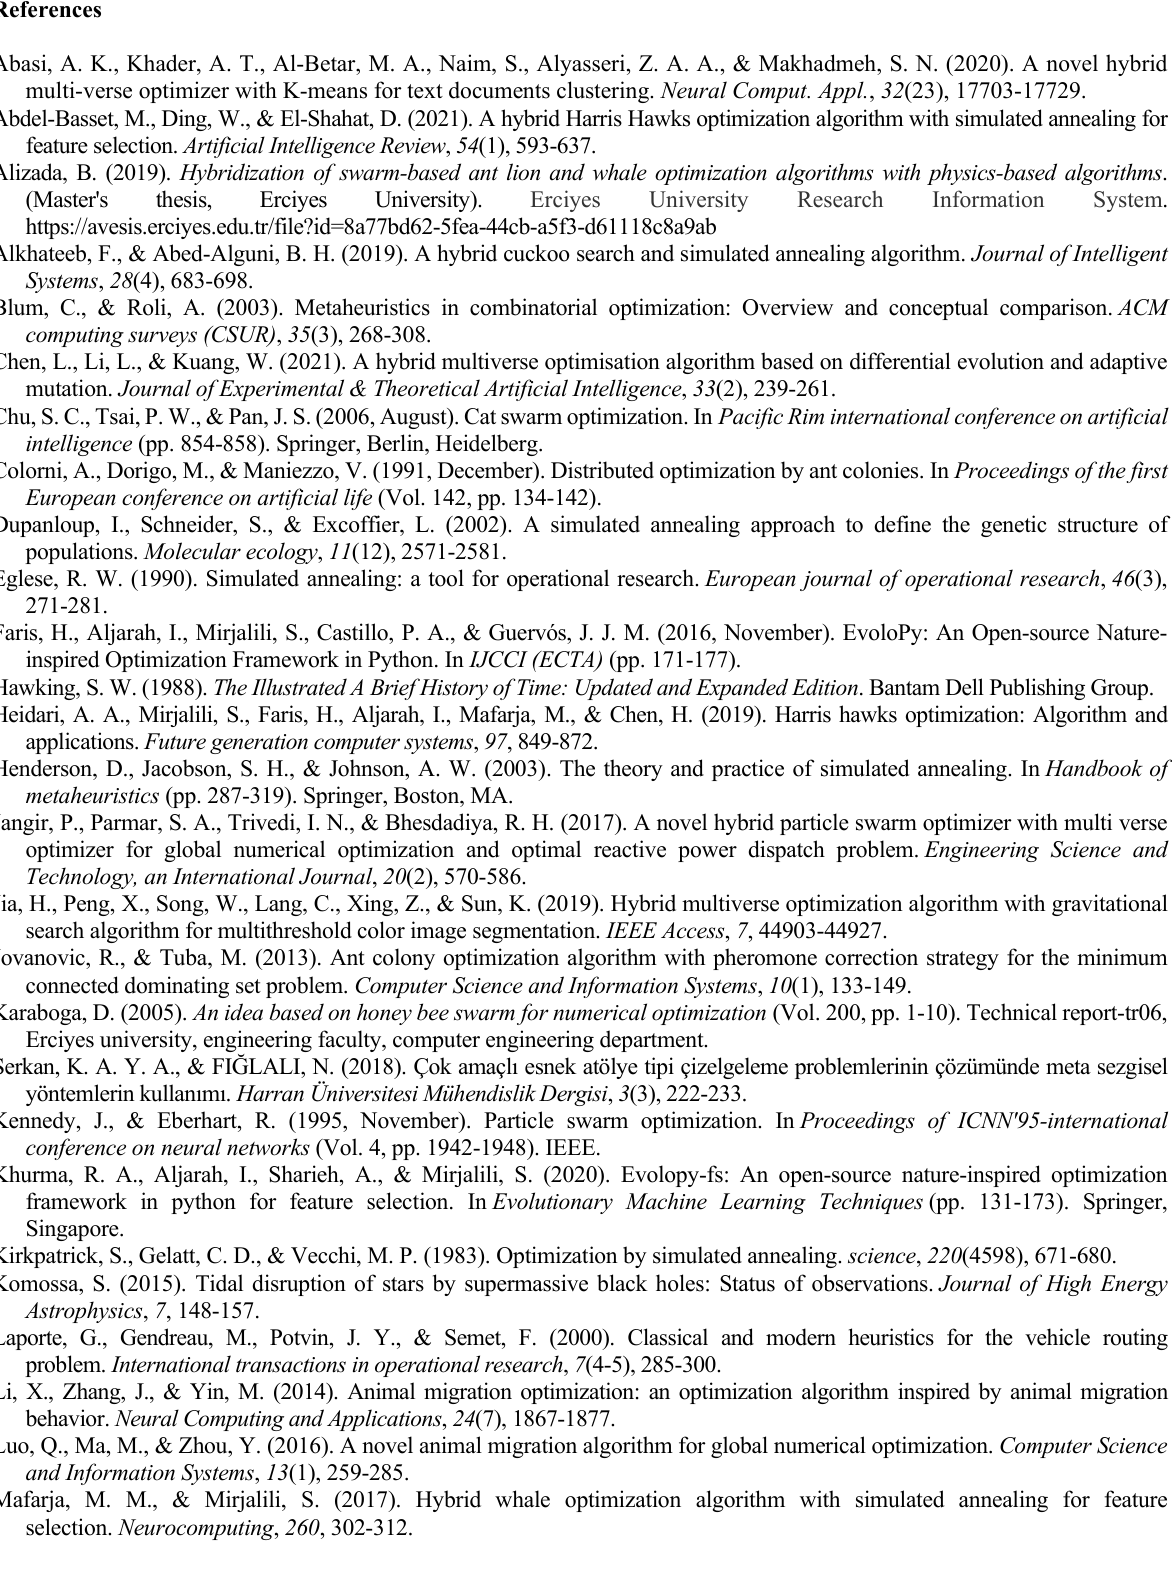
algorithm. Comparison consequences show that the IMVOSA algorithm importantly improves the success of MVO algorithm and performs better than other comparison algorithms. In the future, we intend to apply the proposed IMVOSA algorithm for real engineering problems and training of artificial neural